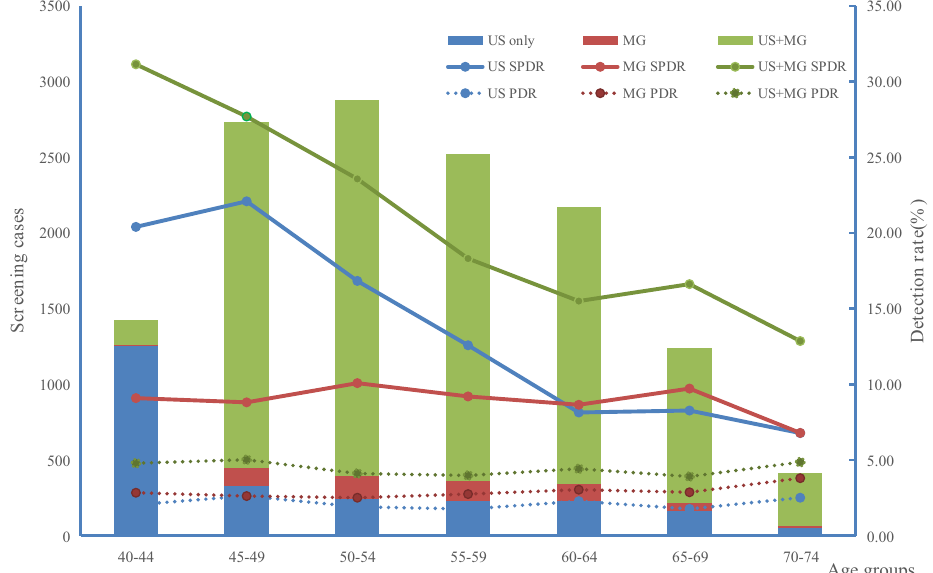
Figure 3. Detection rates for breast cancer by ultrasound, mammography and combined screening: US ultrasound, MG mammography, SPDR suspicious positive detection rates, PDR positive detection rates.